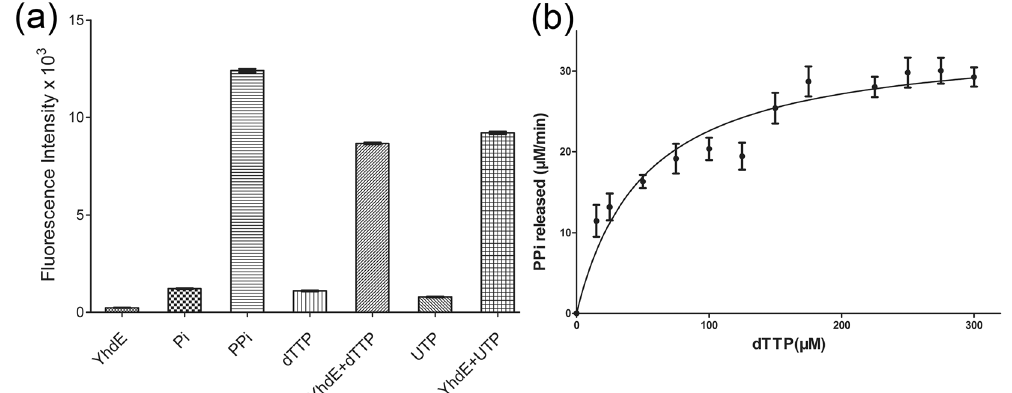
Figure 1. Pyrophosphatase assays of YhdE by fluorescence probe. ( a ) Fluorescence signal of 4-isoACBA- Zn(II) complex (50 μ M) towards various samples in aqueous solution buffered with Hepes (20 mM, pH 7.0). Experimental conditions: 100 μ M Pi, PPi, dTTP and UTP; 100 nM YhdE. ( b ) Kinetic analysis of YhdE_E33A to dTTP. For kinetic measurements, 7.5 μ M YhdE_E33A was assayed under the standard conditions along with increasing concentrations of the substrate